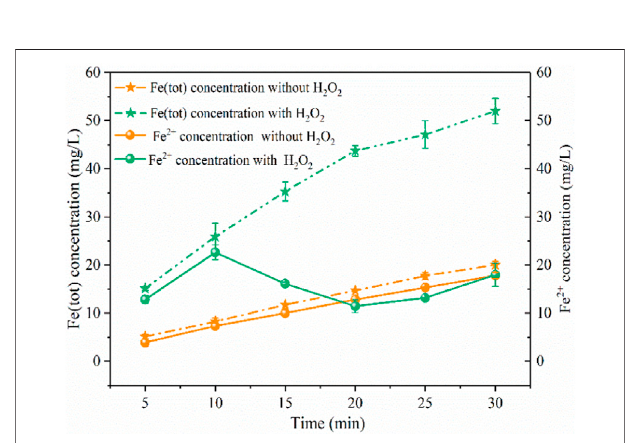
Frontiers in Chemistry |